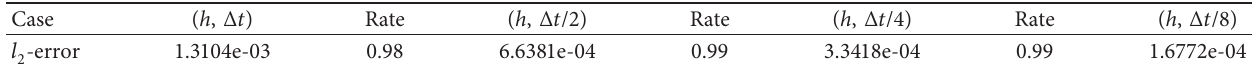
Table 13: Convergence test results of the SAV approach for time step.